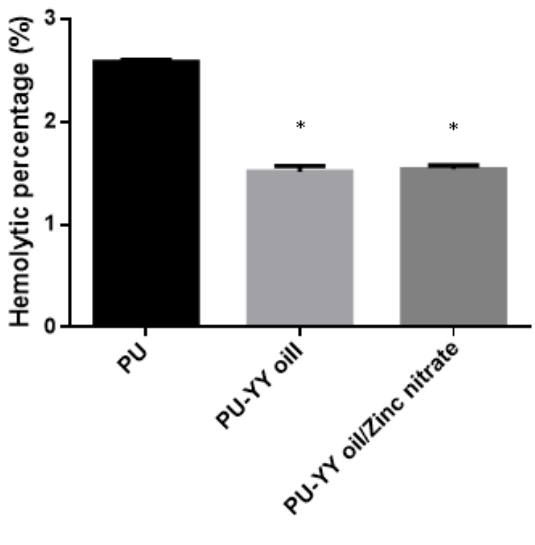
Figure 11. Hemolytic assay of PU, PU/YY and PU/YY/ZnNO 3.